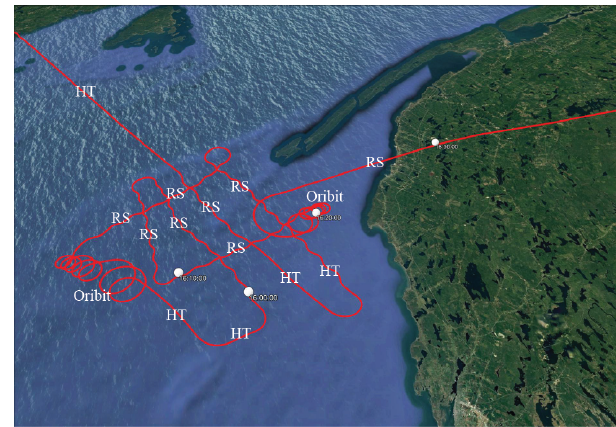
Figure 4. Typical PDPP flight track showing where the aircraft per- formed a series of horizontal transects (HT), roll sweeps (RS) and orbits of various roll